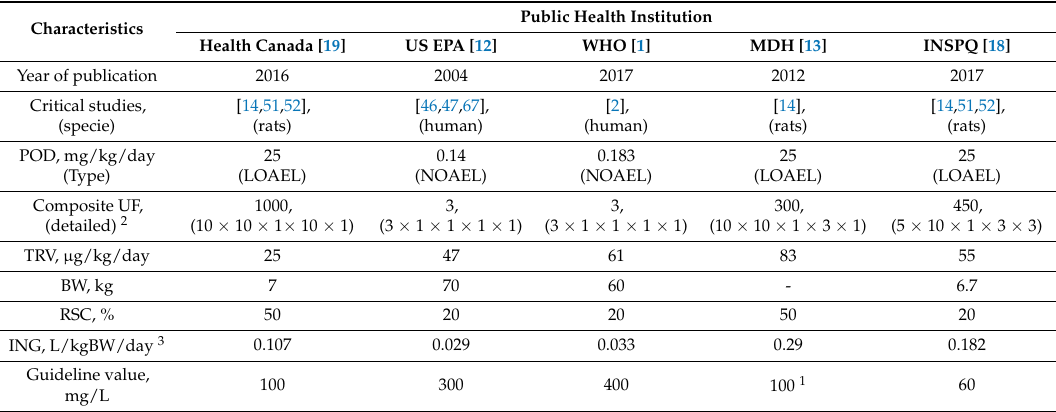
Table 3. Comparison of drinking water guidelines proposed by various public health institutions, including the one derived by the